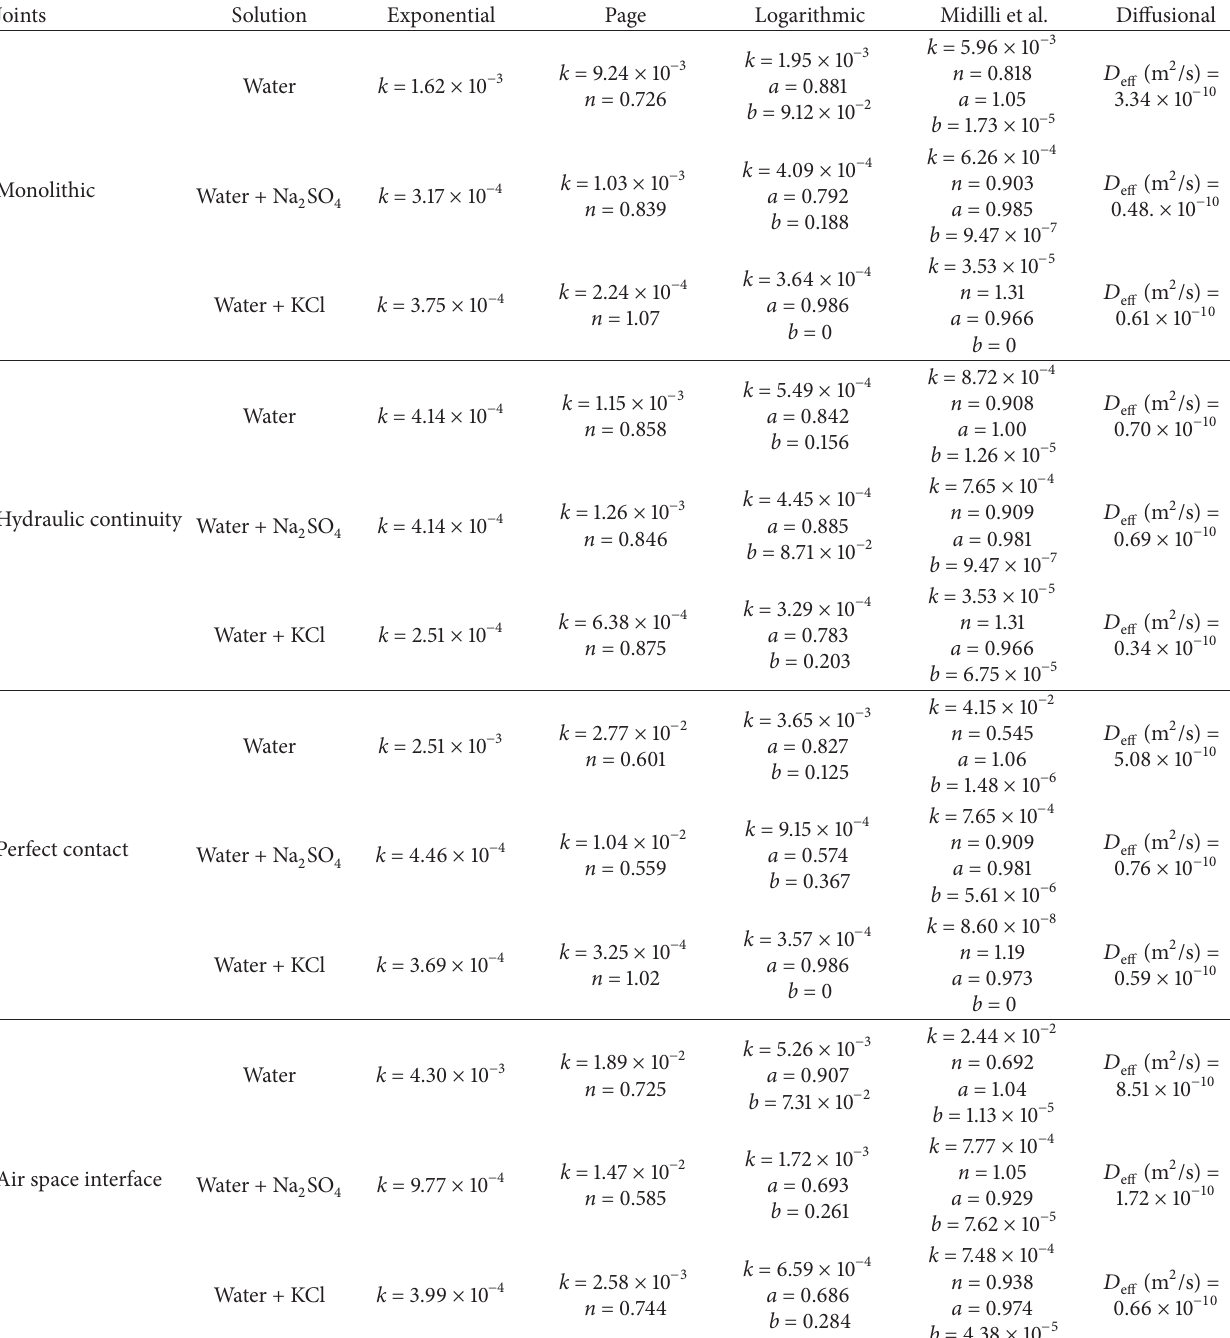
Table 3: Values of empirical constants and drying constant for the models